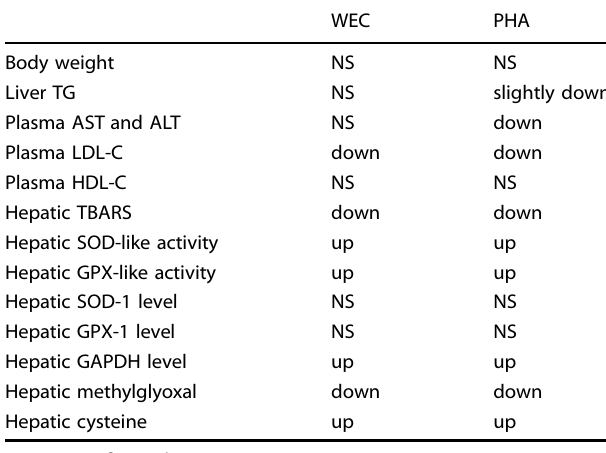
Table 1. Summary for responses by administration of WEC and PHA on mice fed high fat